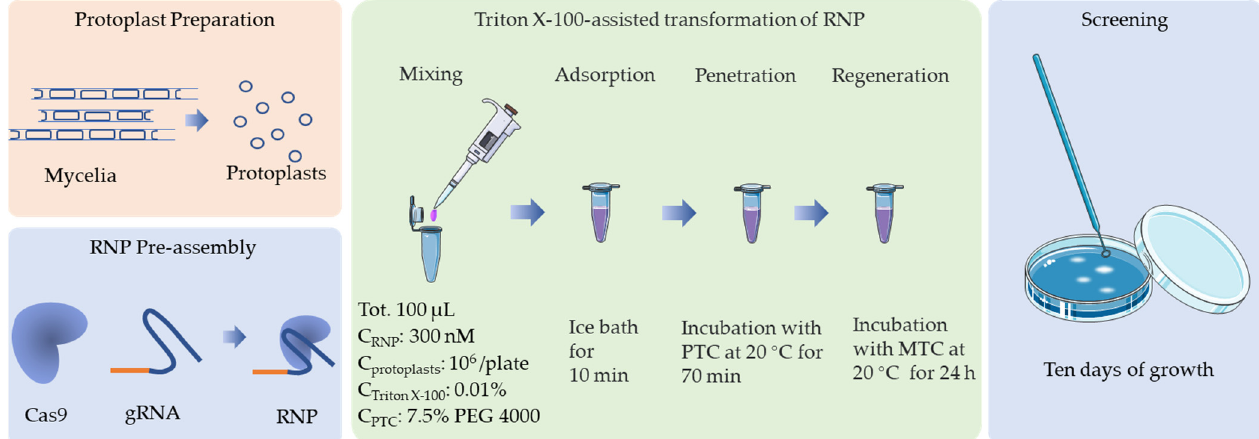
Figure 5. Schematic representation of the optimal protocol for CRISPR/Cas9 transformation of F. filiformis , which is based on an in vitro assembled RNP complex.